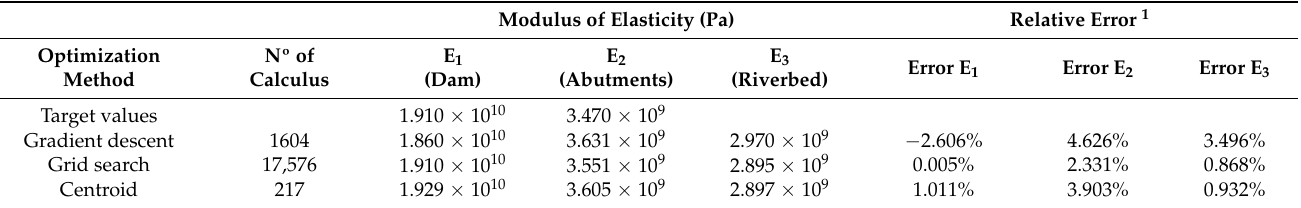
Table 6. Comparison of the results of the different methodologies employed. Dam and foundation divided into riverbed and abutments.